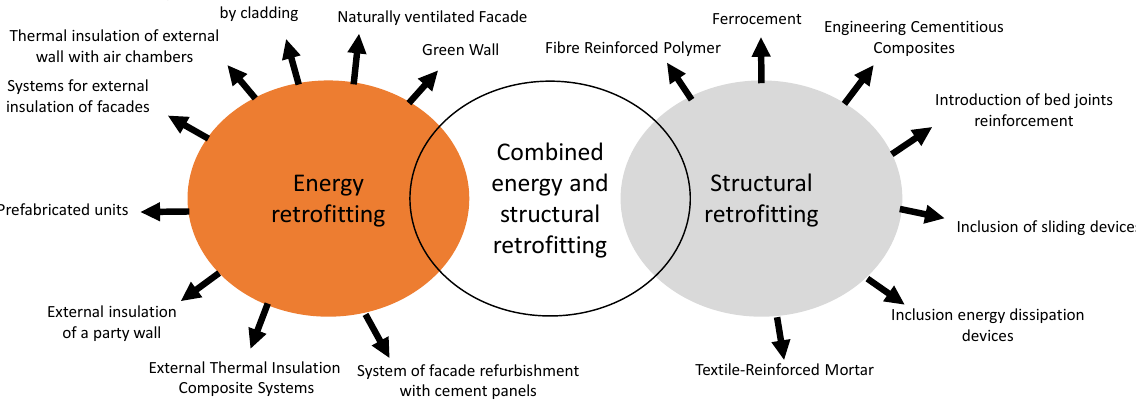
Figure 1. Techniques available for energy and structural retrofitting of masonry infill walls.